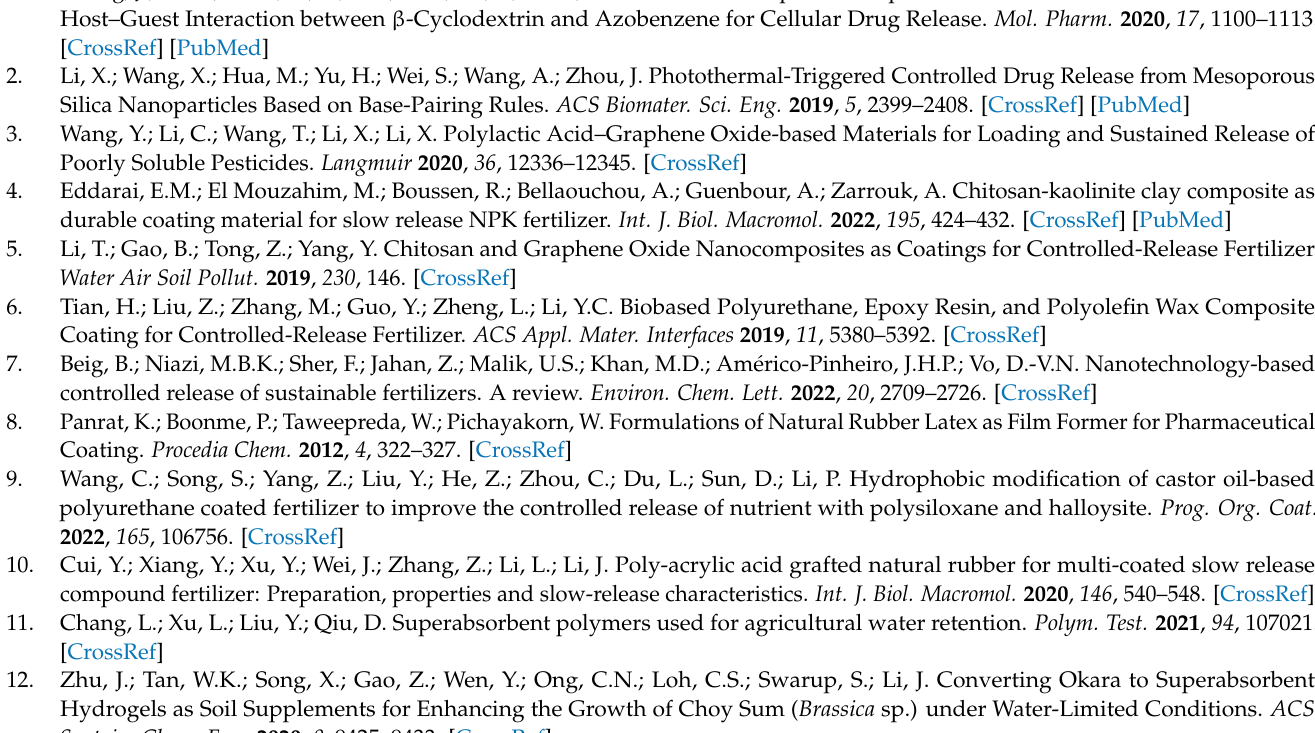
Figure S2: Release data fitted to different kinetic models: (a) zero-order, (b) first-order, (c) Higuchi model and (d) Korsmeyer–Peppas